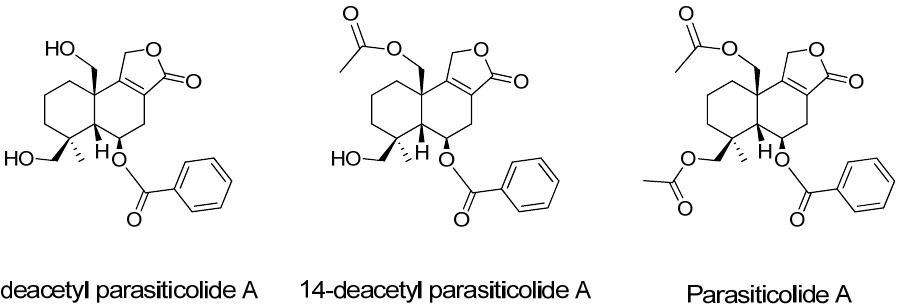
Figure 4. Structures of dide- and 14-deacetyl parasiticolide A and parasiticolide